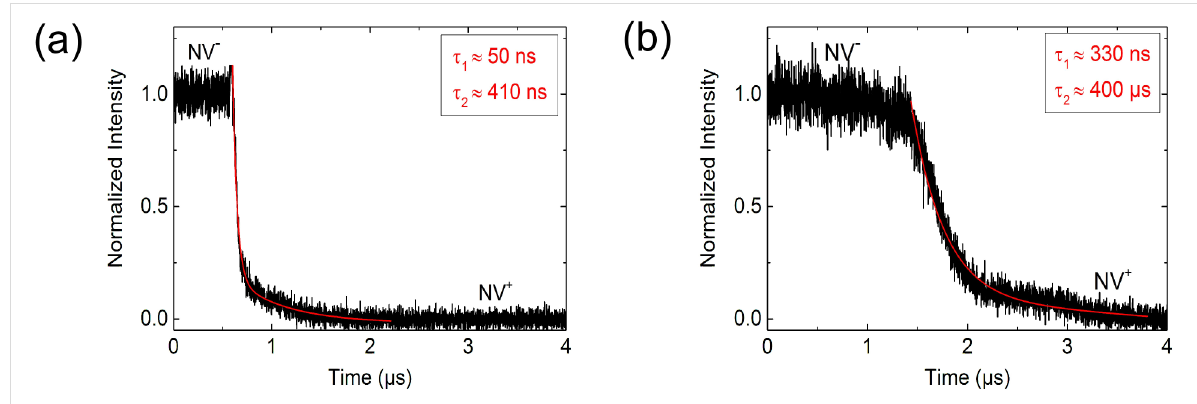
Figure 7: Degradation effect. After several 1000 switching cycles, the measured time constants for discharging NV − increases to (a) approximately 500 ns. After additional several 1000 switching cycles the measured time constant (b) increases by one order of magnitude to approximately 500 µs. This indicates a degradation effect of the diode properties. The reasons for the observed degradation is explained in the text. Since the time constant increases above the time resolution of the measurement setup, we can now measure two time constants for the process of discharging NV − to NV + , indicating a two-step process.